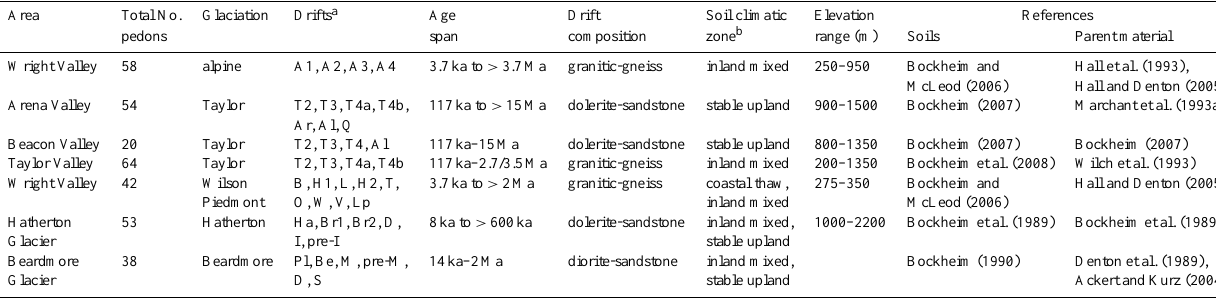
Table 1. Site factors of soil chronosequences in the Transantarctic Mountains. Area